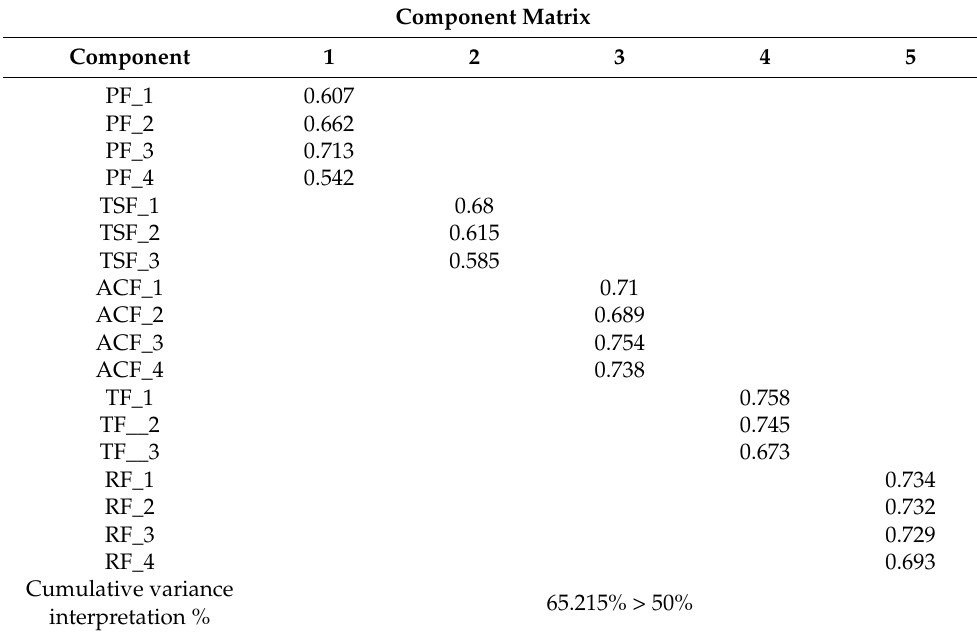
Table 4. Results of the rotated component matrix.